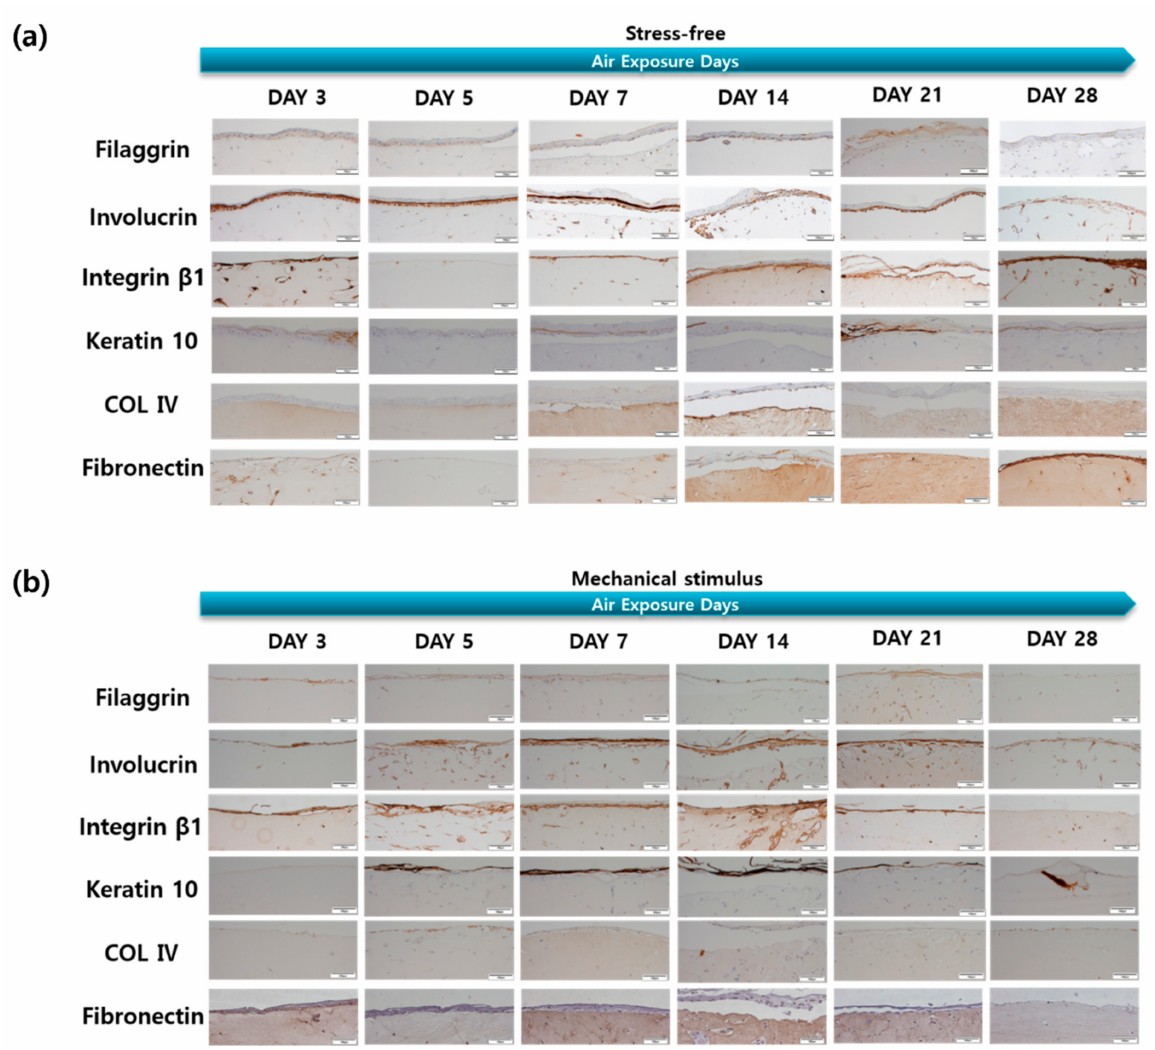
Figure 4. IHC stained images of the filaggrin, involucrin, integrin β -1, keratin 10, collagen IV, fibronectin for the samples ( a ) without and ( b ) with compressive stimulation for various air exposure days (Scale bar = 100 µ